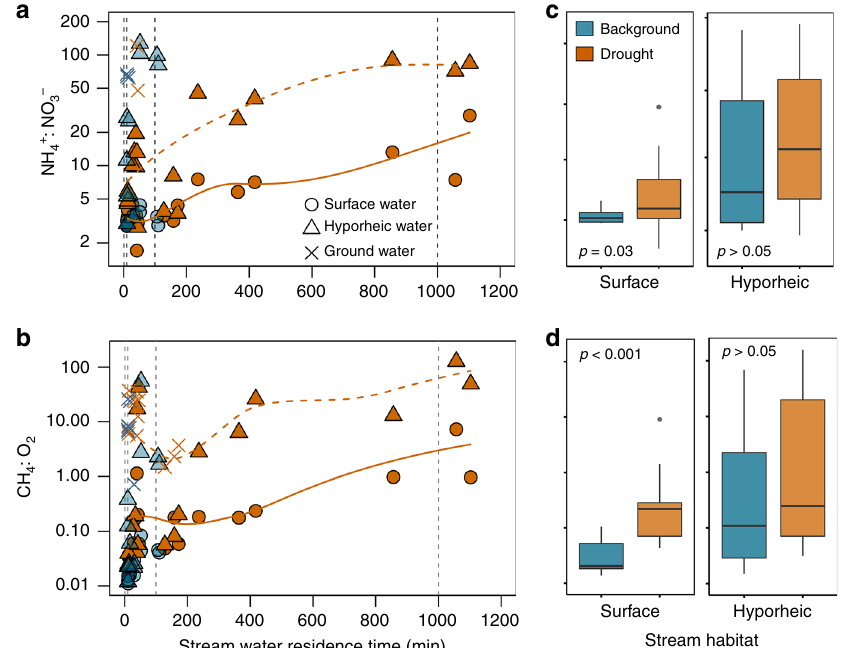
Fig. 3 Experimental drought in fl uenced NH 4 + :NO 3 − and CH 4 :CO 2 ratios. Relationships between the stream water residence time and the molar ratios of a , NH 4 + :NO 3 − and b , CH 4 :O 2 . Orange and blue colors denote drought and background (pre- and post drought) conditions, respectively. Circles and triangles denote surface and hyporheic water observations, respectively. Solid and dashed lines are locally weighted regression model fi ttings (Loess) for surface and hyporheic water observations, respectively. Note that crosses denote observations for groundwater well samples. Panels c and d show differences in NH 4 + :NO 3 − and CH 4 :O 2 ratios between the surface and hyporheic water, respectively. Box plots display the 25th, 50th, and 75th percentiles; whiskers display minimum and maximum values. Differences between hydrological conditions were tested using a nonparametric Wilcoxon Signed- Rank test.